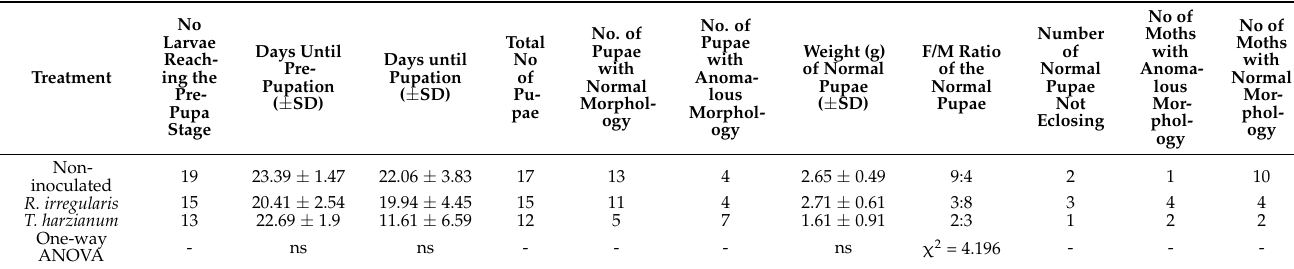
Table 1. Impact of tomato root inoculation by Rhizophagus irregularis or Trichoderma harzianum on Manduca sexta pupation and adult emergence.